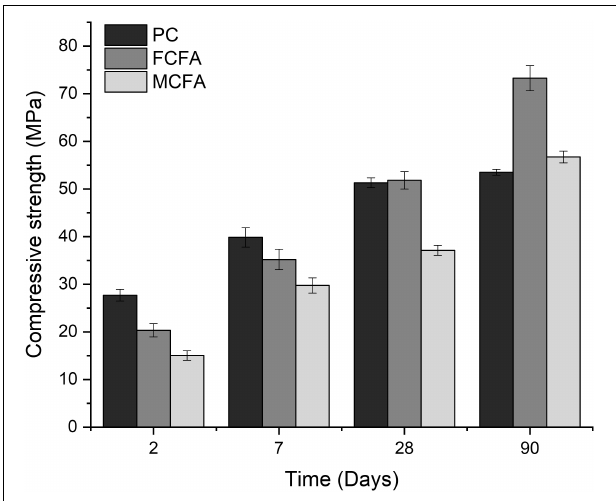
FIGURE 12 | Compressive strength of mortar bars made with classified fly ash blended cements, and Portland cement (CEM I 42.5 R) as